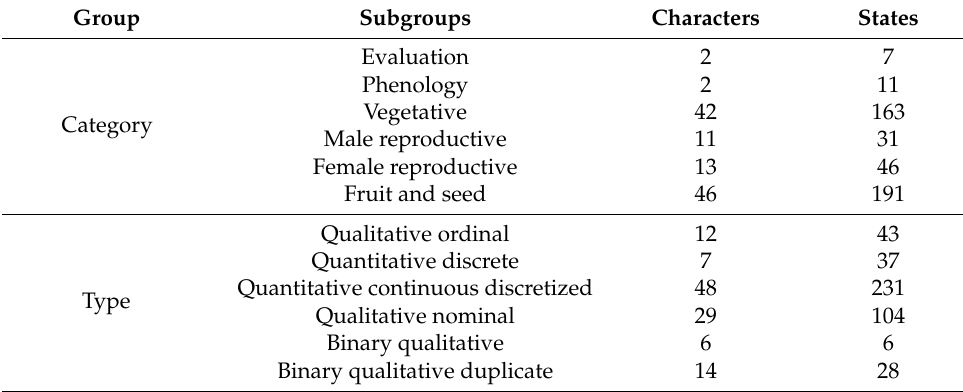
Table 2. Categories and types of characters and their